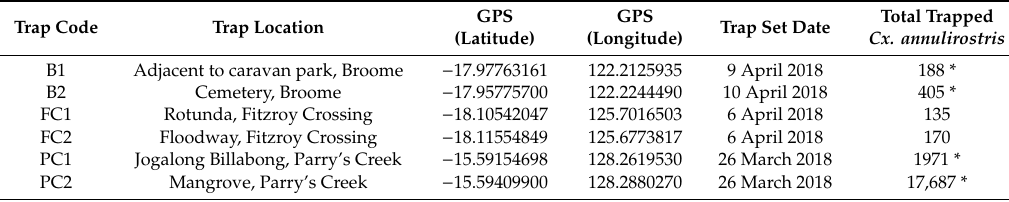
Figure 1. Map of northern Western Australia. Mosquito trap locations for three sites and six traps are marked with a teal diamond. The inset maps indicate the locations of two traps located at each site. The map was prepared using QGIS v2.18.15 [18], OpenStreetMap, Natural Earth, and Mainroads Western Australia [19]. The baselayer shapefile was obtained from the Australian Government data portal [20]. Table 1. Culex annulirostris trapped from three sites in the Kimberley region. GPS—global positioning